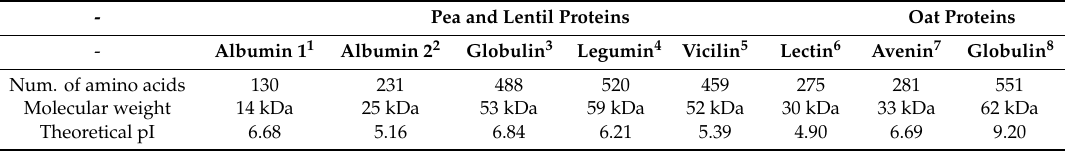
Table 6. Proteins in Pea, Lentil and Oat, with size, weight and